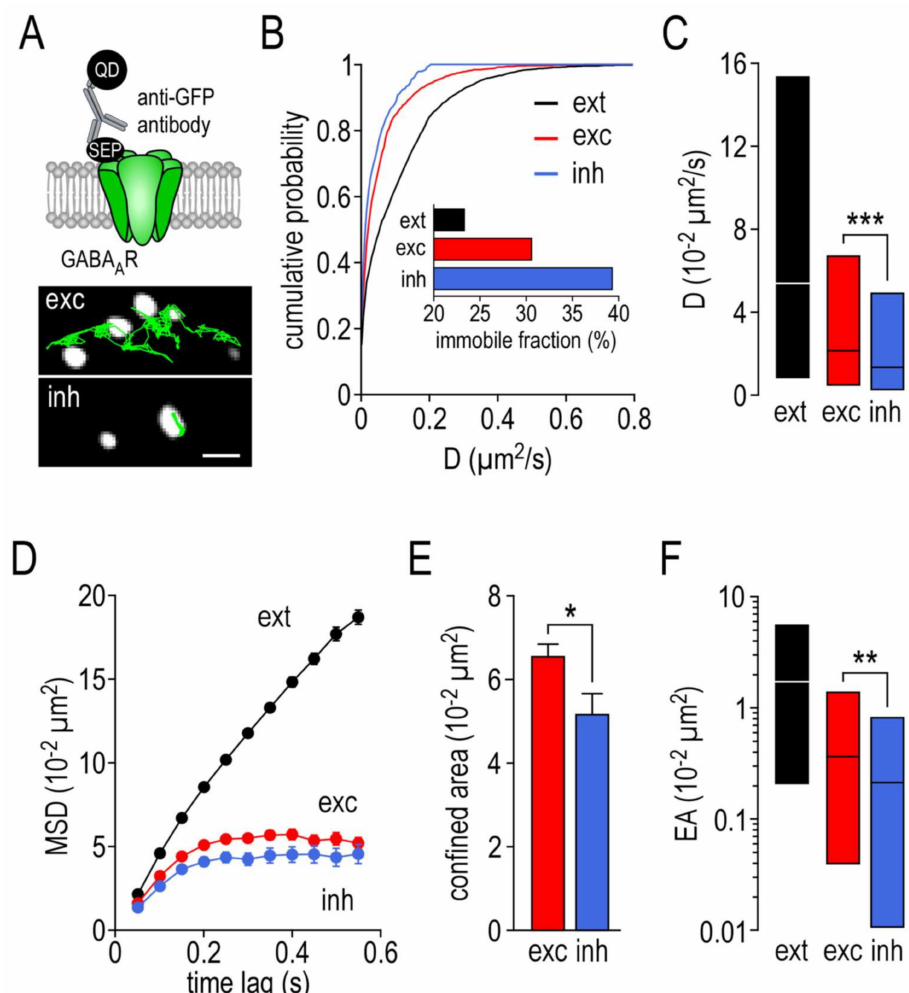
Figure 3. The surface dynamics properties of GABA A receptors at inhibitory synapses differ from the excitatory synapses. ( A ) Cartoon showing the experimental design (upper panel) and examples of trajectories of a single GABA A receptor–SEP–anti-GFP antibody–QD complex (500 frames, 50 ms acquisition) on the dendritic shaft with either identified excitatory (exc) or inhibitory (inh) synaptic areas (lower panel). Scale bar, 350 nm. ( B ) Cumulative probability diffusion coefficient of GABA A receptors at inh or exc synapses compared to extrasynaptic area (ext). The inset shows the immobile fraction (defined as D < 0.005 µ m 2 /s) in the different areas. ( C ) Bar graphs illustrating the instan- taneous diffusion coefficient (D, represented as median ± interquartile range 25–75%) in ext, exc and inh areas. ( D ) Comparison of GABA A receptors mean square displacements (MSD, represented as mean ± SEM) in ext, exc and inh areas. ( E ) bar graphs illustrating the confined area (for the time period of 250–550 ms and represented as mean ± SEM) in exc and inh areas. ( F ) Bar graphs illustrating the explored surface area (EA, represented as median ± interquartile range 25–75%) in ext, exc and inh areas. * p < 0.05, ** p < 0.01, *** p < 0.001. Nonparametric Mann–Whitney